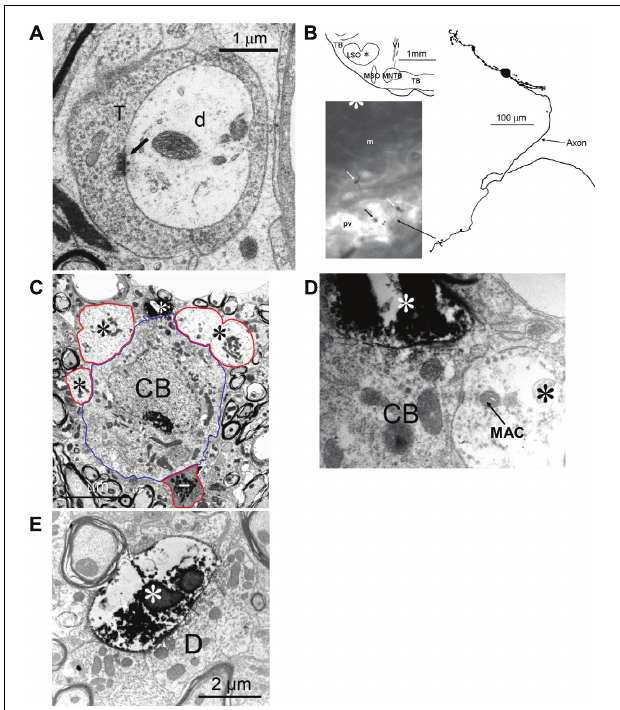
FIGURE 4 | Connections between the LNTB, SPON and LSO. (A) Synaptic terminal of an mLNTB cell axon collateral on a dendrite in the SPON. Arrow indicates synaptic specialization. T: mLNTB synaptic terminal; d: SPON dendrite. (B–E) The LSO projects to the LNTB. (B) Efferents from a labeled LSO neuron form large endings in the pvLNTB. Top left: Location of the LSO cell body. Right: Camera lucida drawing of the LSO principal cell. The main axon initially headed ventrally then turned medially on its way to the ipsilateral IC. Bottom left: at the point where the main axon turns medially an axon collateral is given off that heads ventrally into the LNTB. The swellings seen toward the end of this collateral are indicated with arrows. (C) Electron micrograph of one of the swellings of the LSO axon collateral, shown in A, synapsing (white asterisk at 12 o’clock) on a pvLNTB cell body (blue outline) that is also contacted by several large presynaptic terminals (red outlines, black asterisks). Larger profiles of the LSO terminal seen in adjacent sections are not shown. Also contacting the cell body is what appears to be an inhibitory terminal with a darker axoplasm (red outline, white dash). (D) Enlarged electron micrograph of the same labeled LSO axon terminal (white asterisk) shown in (C) synapsing on a pvLNTB cell body (CB), immediately adjacent to a large unlabeled terminal (black asterisk) that contains a structure resembling a “mitochondrial-associated adherens complex” (MAC). MACs are also found in cat GBC axon terminals in pvLNTB (Spirou et al., 1998). (E) Electron micrograph of another LSO axon terminal (white asterisk) synapsing on a large dendrite (D) in pvLNTB.